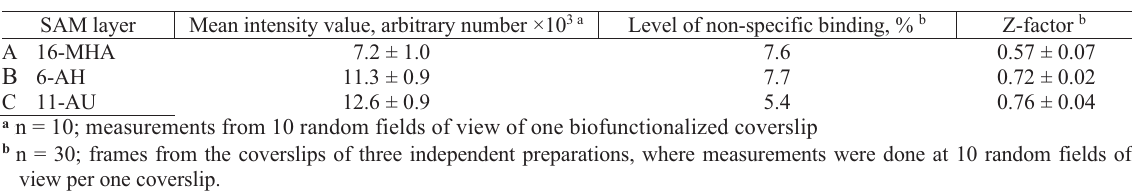
Table 1. Intensity values and quality factors of different biofunctionalized SAM